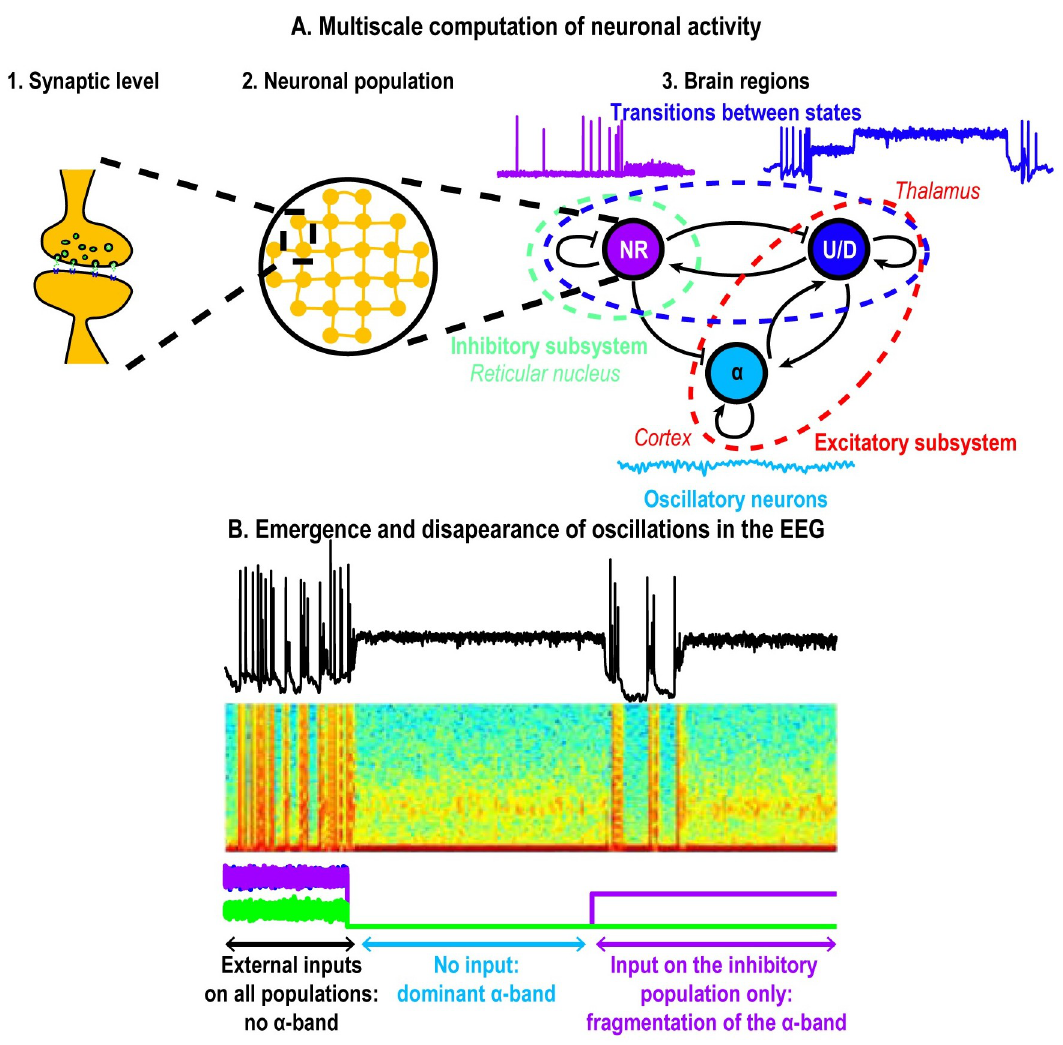
Fig 8. Computational principle underlying the α -band dynamics. A: Multiscale models 1. synaptic level: short-term facilitation and depression mechanisms, 2. neuronal population: mean voltage fluctuations and 3. interactions between different brain regions (thalamus and cortex, models 5 and 6) resulting in the different activity patterns observed in EEG at a global scale. B: α -band emerges in the Up-state due to noise but can be altered by external inputs.